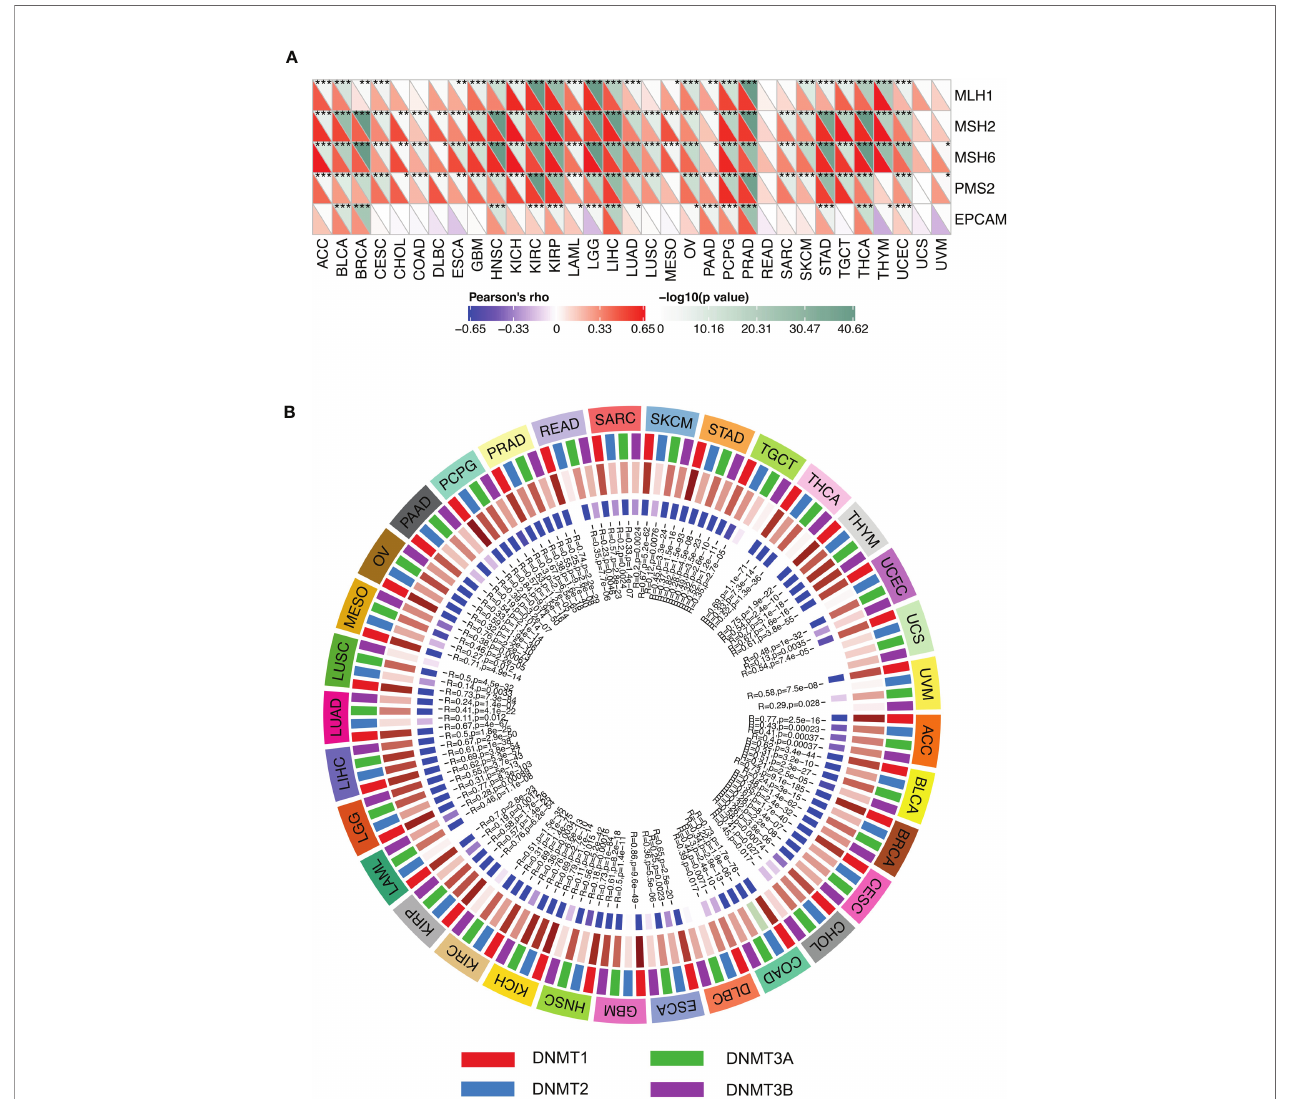
FIGURE 8 | Expression levels of SMARCA4 correlate with fi ve MMR genes and four DNA methyltransferases. (A) Spearman ’ s correlation analysis of SMARCA4 expression with expression levels of fi ve MMR genes across cancers (* p < 0.05, ** p < 0.01, *** p < 0.001). (B) Spearman ’ s correlation analysis of SMARCA4 expression with four DNA methyltransferases across